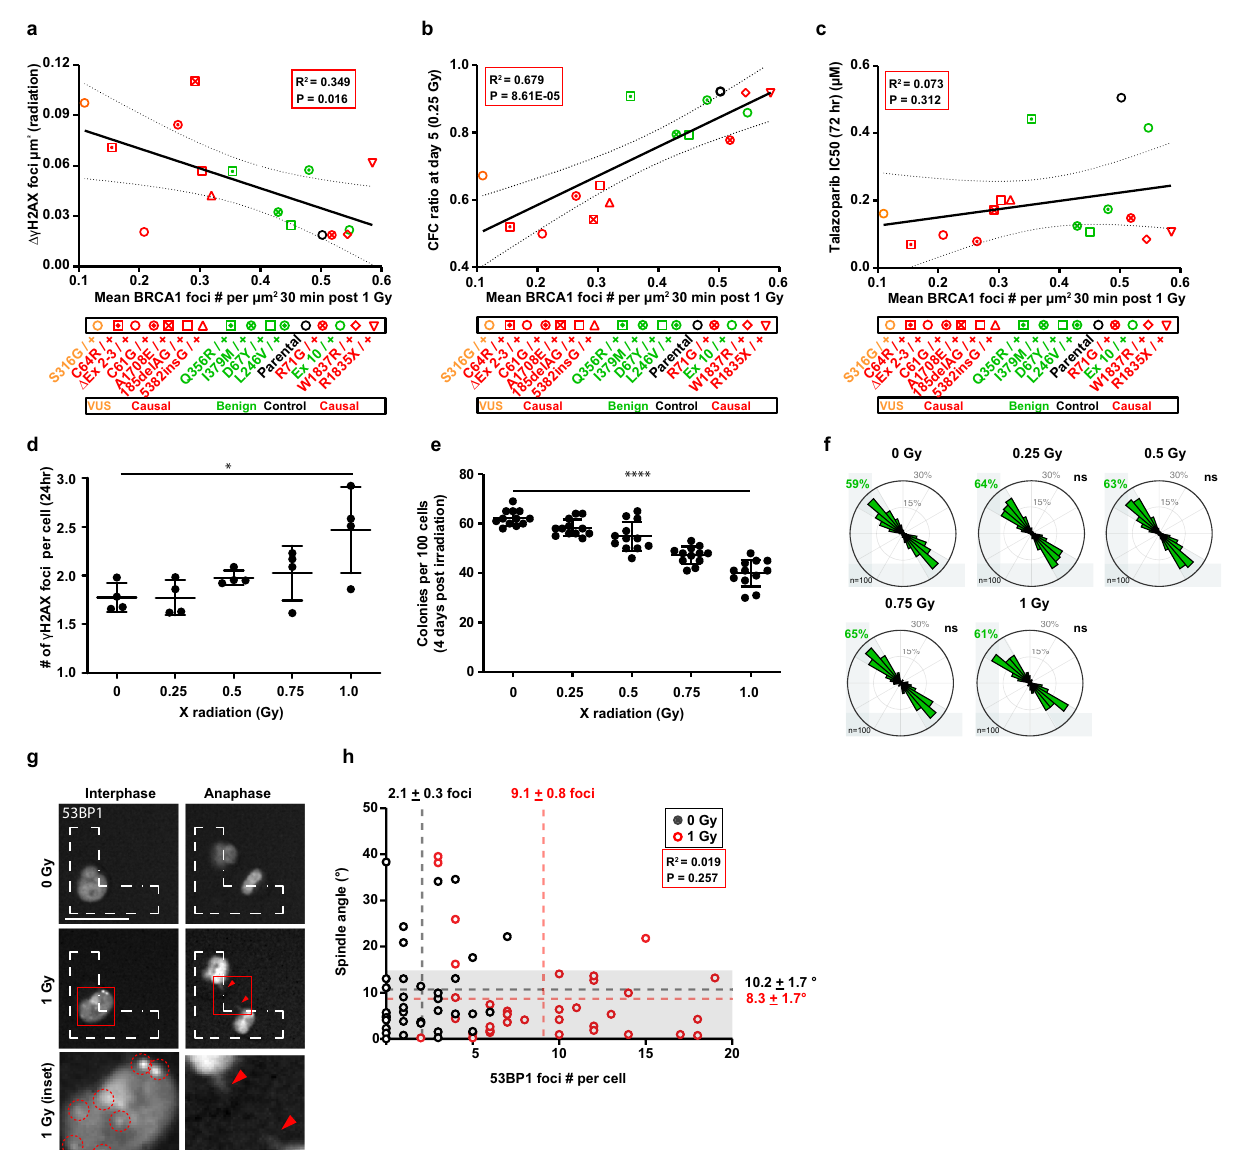
Fig. 4 DNA damage is not suf fi cient to misorient cell divisions. a Correlation plot of mean BRCA1-positive foci per µ m 2 nucleus area and γ H2AX-positive foci per µ m 2 nuclear area for parental or BRCA1 mutant/ + MCF10A cells. BRCA1 foci were measured 30 min after X-radiation (1 Gy). γ H2AX-positive were measured 24 h after X-radiation (1 Gy) and normalized to basal levels in sham-treated cells ( Δγ H2AX). Plotted values include a simple linear regression (goodness of fi t, R 2 = 0.349, P = 0.016) and dashed lines indicate the 95% con fi dence band. In all panels, parental cells are in black text and BRCA1 mutant/ + MCF10A cells edited to encode a benign variant ( n = 5) is in green text, a pathogenic variant ( n = 9) is in red text, or a VUS ( n = 1) is in orange text. b Correlation plot of mean BRCA1-positive foci per µ m 2 nucleus area and colony-forming cell (CFC) ratio measured at day 5 after 0.25 Gy X-radiation for parental or BRCA1 mutant/ + MCF10A cells. Plotted values include a simple linear regression (goodness of fi t, R 2 = 0.679, P = 8.61E − 05) and dashed lines indicate the 95% con fi dence band. c Correlation plot of mean BRCA1-positive foci per µ m 2 nucleus area and Talazoparib inhibitory concentration 50 (IC50) measured after 72 h for parental or BRCA1 mutant/ + MCF10A cells. Plotted values include a simple linear regression (goodness of fi t, R 2 = 0.073, P = 0.312) and dashed lines indicate the 95% con fi dence band. d Number of γ H2AX-positive foci in parental MCF10A cells 24 h after X-radiation (mean± SD, 4 wells from duplicate experiments, n = 160 cells per well). * P = 0.0105; one-way ANOVA. e Colony-forming cells per 100 parental MCF10A cells plated measured 4 days after X-radiation (mean ± SD; 6 wells from duplicate experiments per dose, 100 cells seeded per well). **** P < 1E − 15; one-way ANOVA. f Circular graphs show the distribution of cell division angles measured in 10°-wide sectors at anaphase for parental MCF10A cells. Cells were imaged for 24 h after X-radiation (50 mitotic cells per experiment, duplicate experiments). ns = not signi fi cant; Mann – Whitney test. Gray percentages indicate the percent of total mitotic cells examined. g Parental MCF10A cell division on fi bronectin-coated, L-shaped micropatterns after transfection with mCherry- 53BP1 and sham or 1 Gy X-radiation. Representative images indicate mCherry-53BP1-positive foci (inset magni fi ed) and lagging chromosomes in an irradiated MCF10A cell. h Mean spindle angle is plotted versus mean mCherry-53BP1 foci per cell ( n = 2 experiments, 35 mitotic cells total examined) for sham-treated (black) or X-radiated (1 Gy, red) MCF10A cells. Spindle angles <15° (highlighted in gray area) were considered as correct spindle orientation. Scale bar = 20 μ m. Values are analyzed with a simple linear regression (goodness of fi t, R 2 = 0.019, P = 0.257). Dashed lines indicate the mean ±